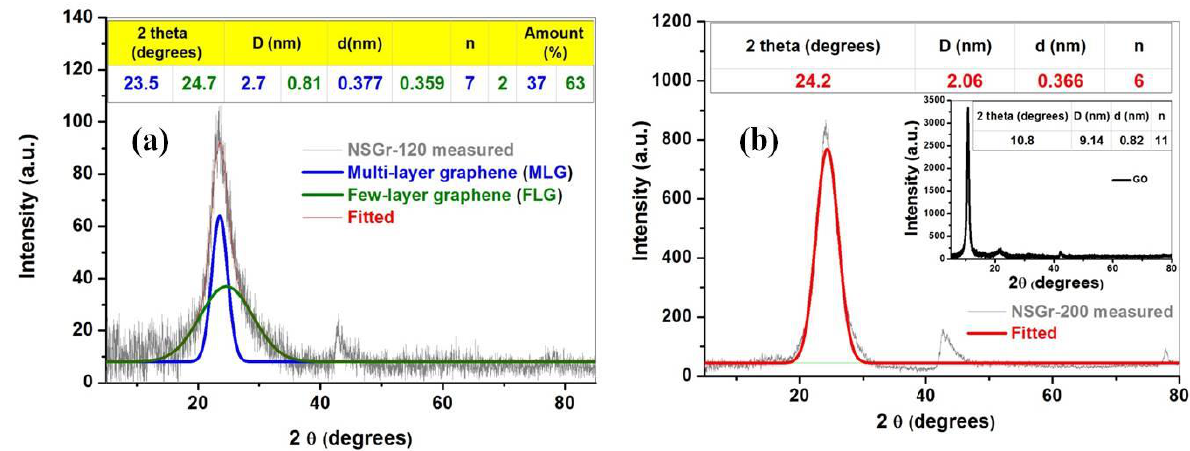
Figure 5. XRD pattern and structural parameters of NSGr-120 sample ( a ) and NSGr-200 sample ( b ); Inset in ( b ): the diffraction pattern of GO.